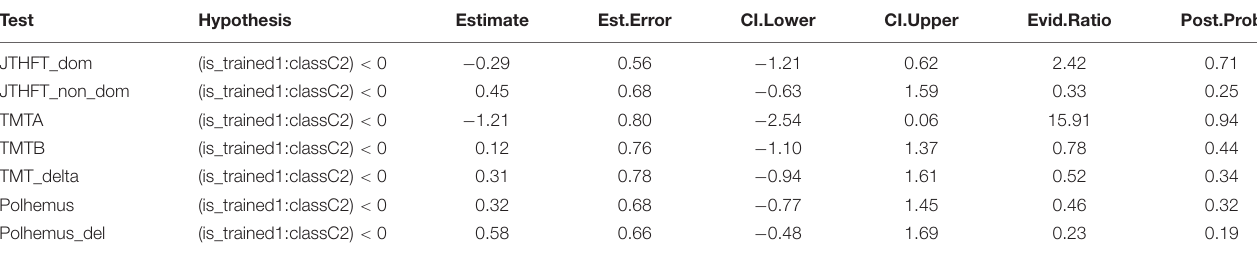
TABLE 7 | Hypothesis tests on differences of the effect of training between classes C1 and